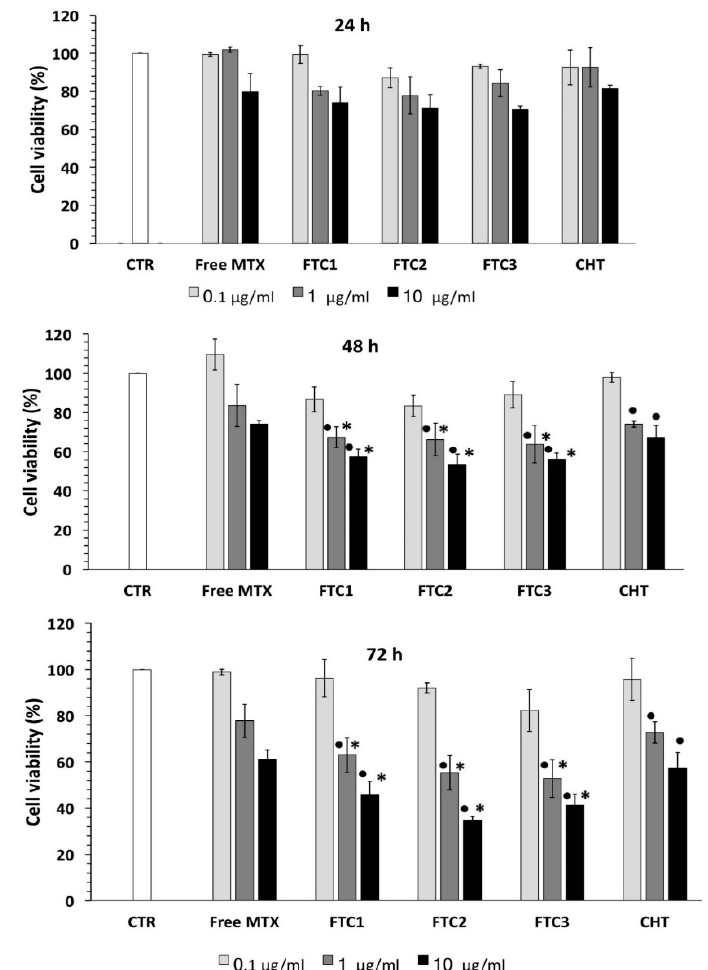
Figure 6. HeLa cell viability after incubation with free MTX, MTX-loaded FTC-NPs, and MTX-loaded CHT-NPs at 0.1, 1, and 10 µM for 24, 48, and 72 h evaluated using the MTT assay. The results are expressed as the percentage of the control assumed as 100%. Each value represents the mean ± SD of three independent experiments. • p < 0.05 vs. control; * p < 0.05 vs. CHT-coated liposome-treated cells.